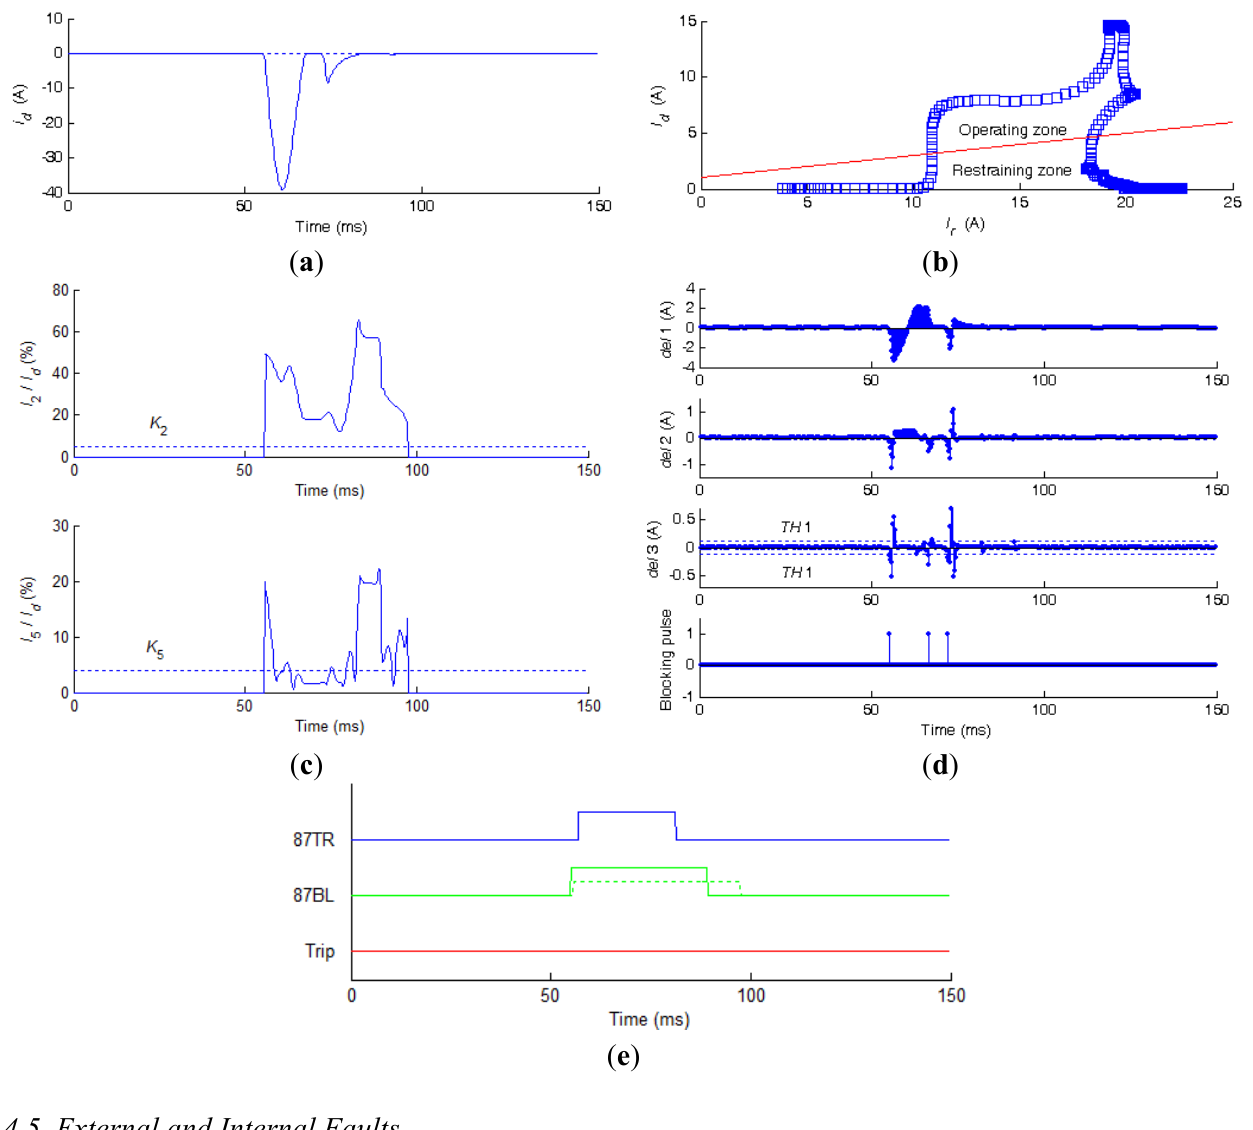
, and blocking pulse; and ( e ) 87TR, 87BL, and trip d